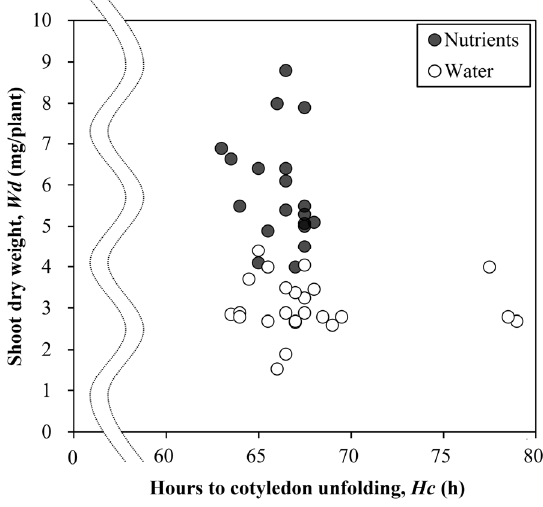
Figure 3. Hours to cotyledon unfolding (from sowing to the unfolding of the cotyledon) of individ- ual plants ( Hc ) and shoot (cotyledon, true leaves, hypocotyl, and petiole) dry weight of individual plants 216 h after sowing (HAS) ( Wd ) with nutrients and